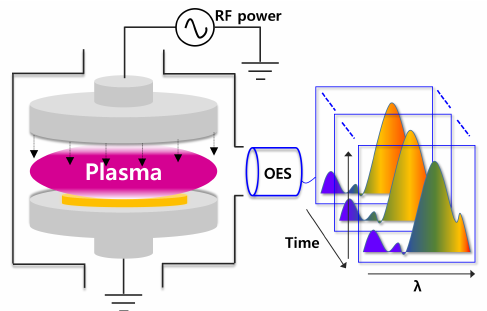
Figure 3. A schematic illustration of plasma etching process and multi-wavelength data obtained from optical emission spectroscopy (OES).